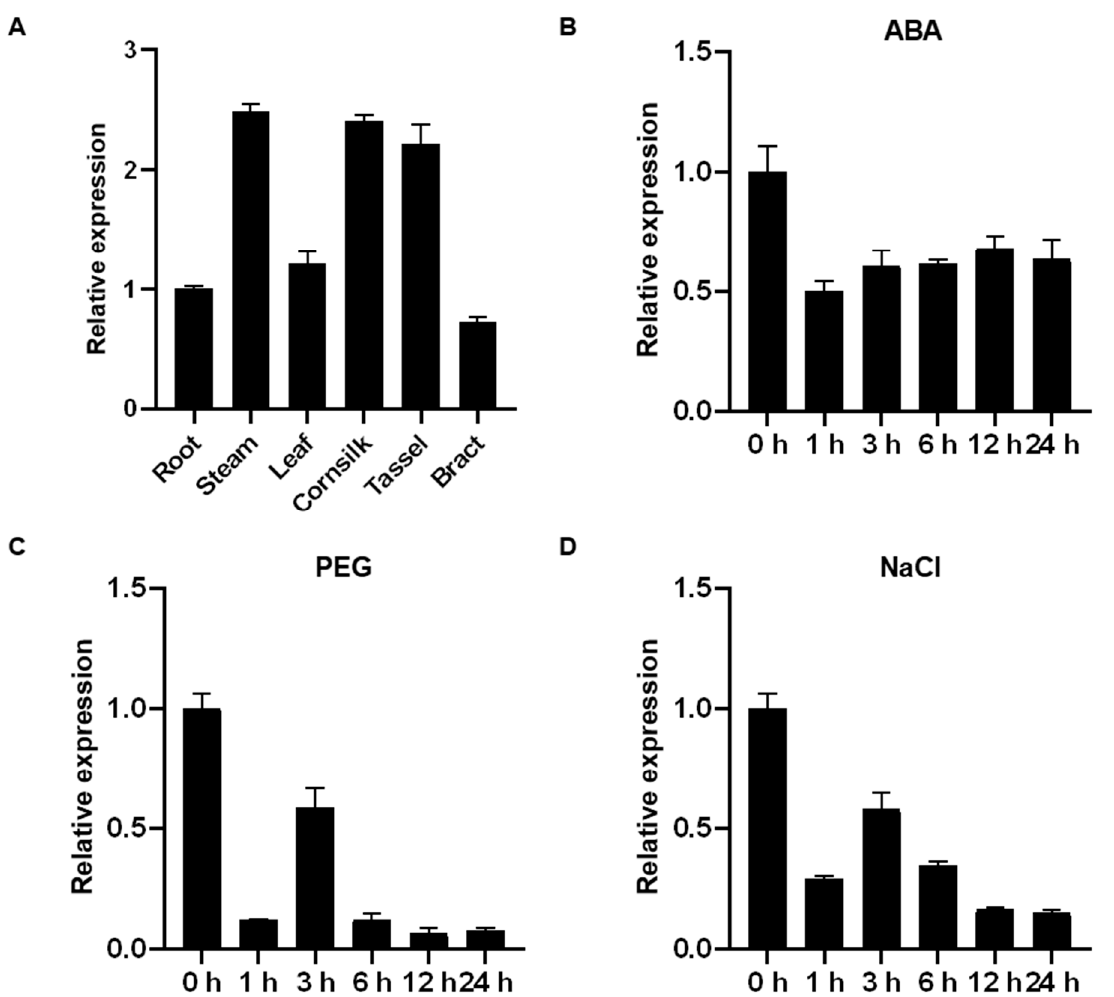
Figure 3. Expression patterns of ZmHsf08 . ( A ) RT-qPCR analysis of ZmHsf08 expression in six tissues (roots, stem, leaves, cornsilk, tassels and bract). ( B – D ) Expression analysis of ZmHsf08 under ABA, PEG, and NaCl treatments. The three-leaf stage seedlings were treated with ABA, PEG, and NaCl, and the expression levels of ZmHsf08 were detected by RT-qPCR. Bars represent means ± SD ( n = 3 repeats).